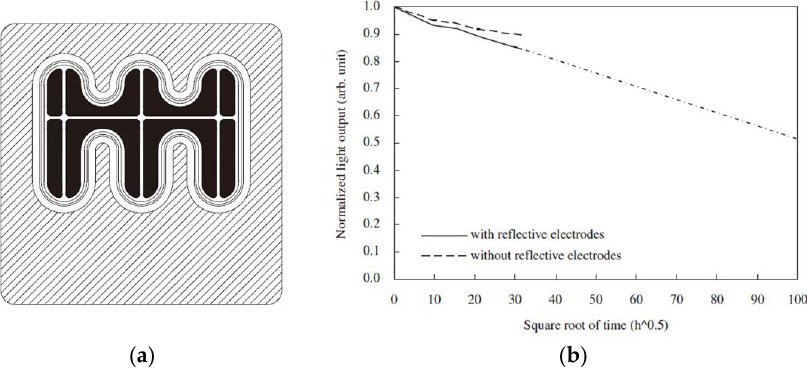
Figure 6. ( a ) Meshed p-GaN contact pattern is shown by narrow white lines besides the black area, which preserves the reflective area (black). Beside the hatched zone, a closed curve zone (white) indicates the Al-based n-contact area with annealing treatment. ( b ) Result of the reliability test. The reduction in the lifetime was suppressed. The reliability test was carried out at as low as 20 mA to avoid the further reduction in the lifetime. (( a , b ) are permitted to be reused from Jpn. J. Appl. Phys. [40]. © Japan Society Applied